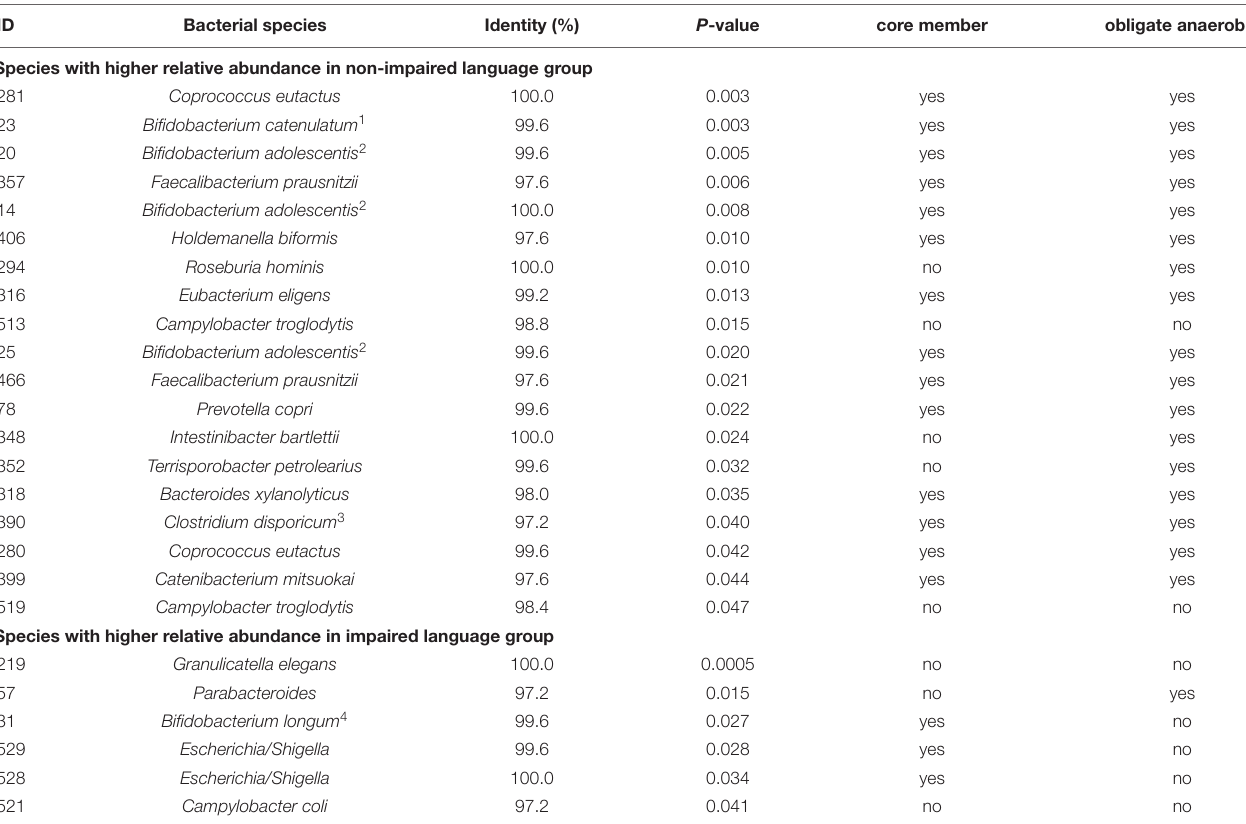
TABLE 2 | Two-tailed Mann–Whitney U test for relative abundance of bacterial species equal or above average and below average language ability